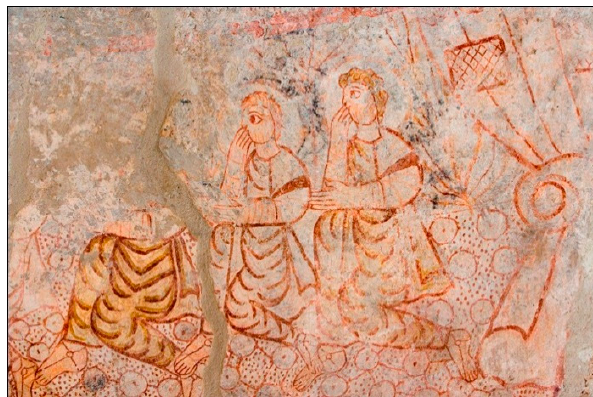
Figure 18. Sant Miquel de Terrassa, wall paintings. Detail of the draperies. © Teresa Llordés (with kind permission).